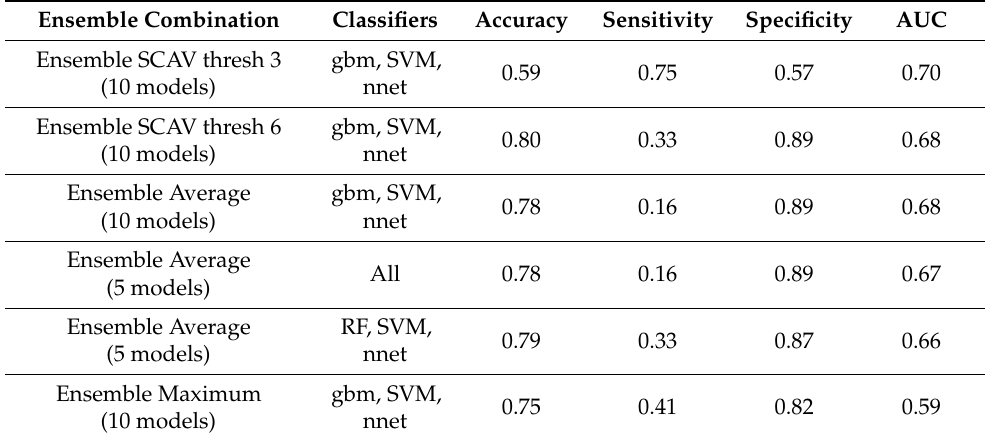
Table 4. EGFR mutation prediction best results on Test dataset, ensembles.